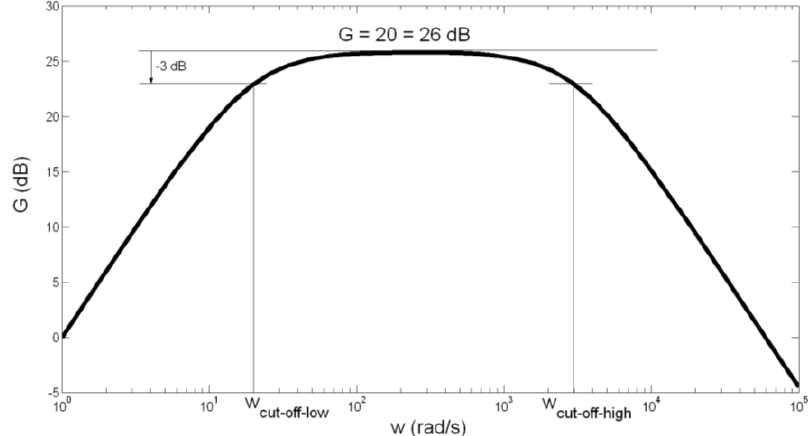
Figure 5. Amplitude-frequency characteristic of the main amplifier acting as a band-pass